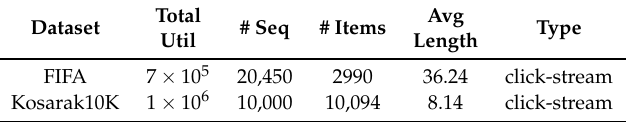
Table 2. Additional datasets used in testing for experiment